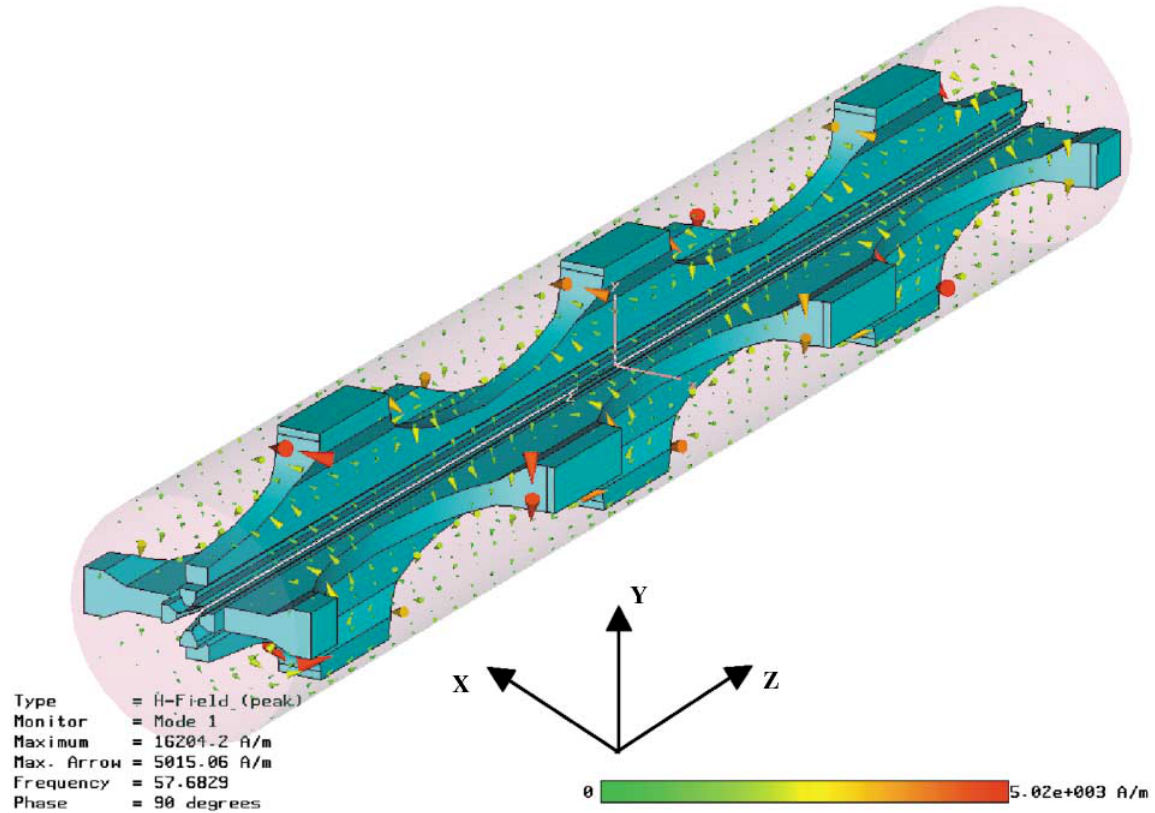
FIG. 11. (Color) Full length model of the RFQ cavity designed using the MWS code. The arrows show the magnetic field directions.